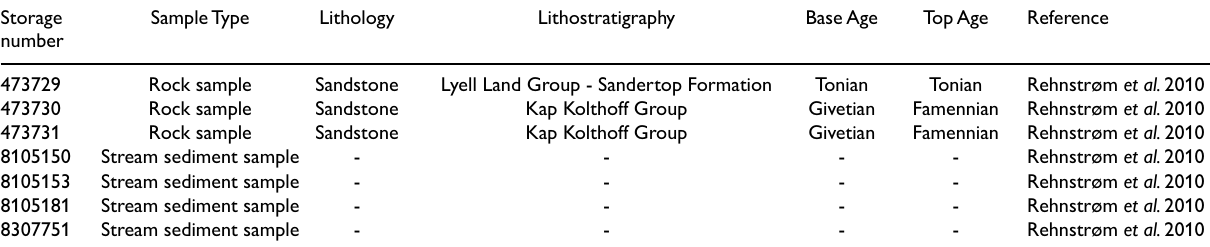
Table 2. Example metadata available for the seven samples in Fig.